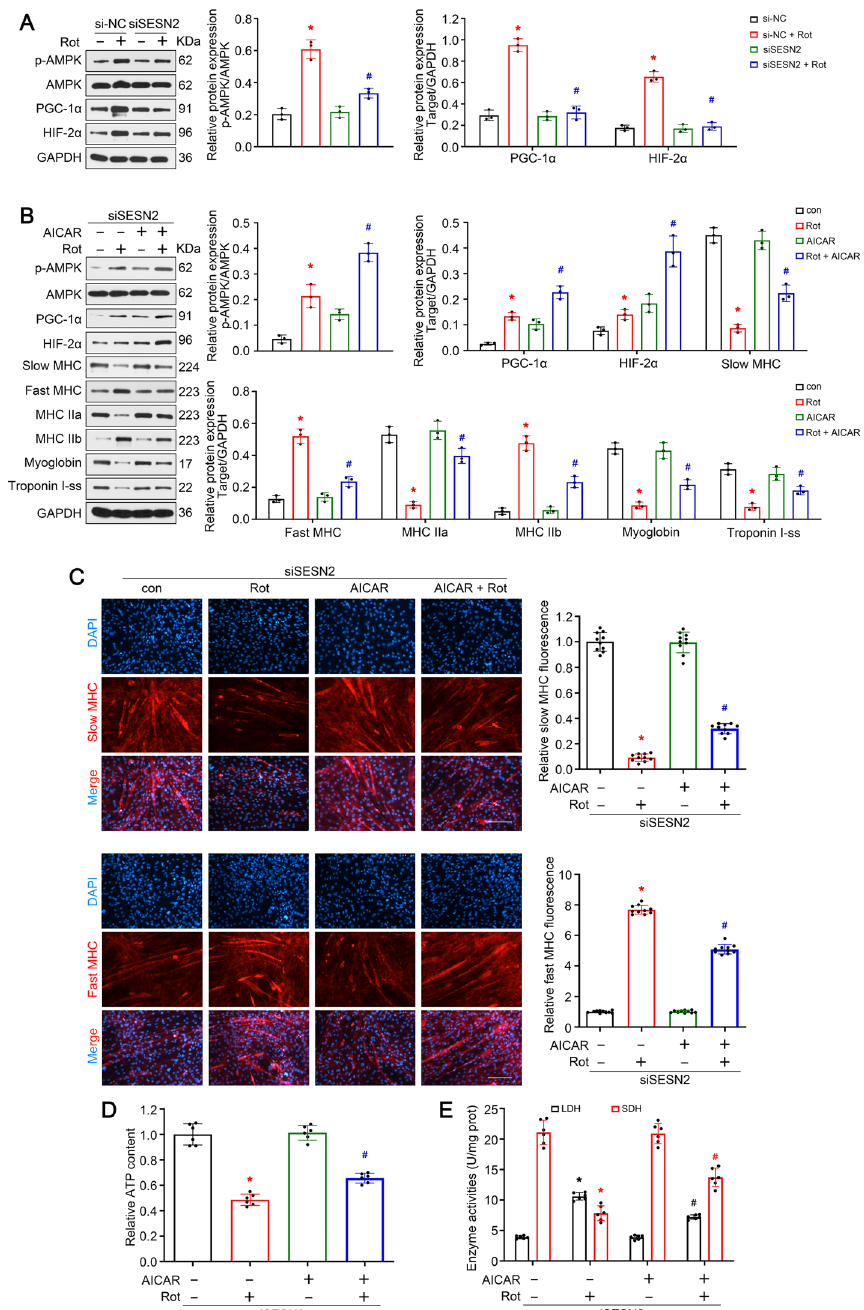
Fig. 5 SESN2 prevented slow-to-fast shift in rotenone-treated C2C12 myotubes via AMPK/PGC-1α pathway. A Western blot analysis of the regulatory effect of SESN2 on the activity of AMPK/PGC-1α signaling. B Western blot analysis of C2C12 myotubes treated with rotenone and AICAR (an AMPK activator) to confirm the role of AMPK/PGC-1α signaling in myofiber type transition. C Immunofluorescence analysis of slow and fast MHC. Scale bar, 50 μm. D , E Detection of relative ATP content and metabolic enzyme activity (LDH and SDH) in C2C12 myotubes. Data presented as mean SD. * P < 0.05 versus control or siNC group. # P < 0.05 versus ± rotenone treatment group. Rot rotenone, Con